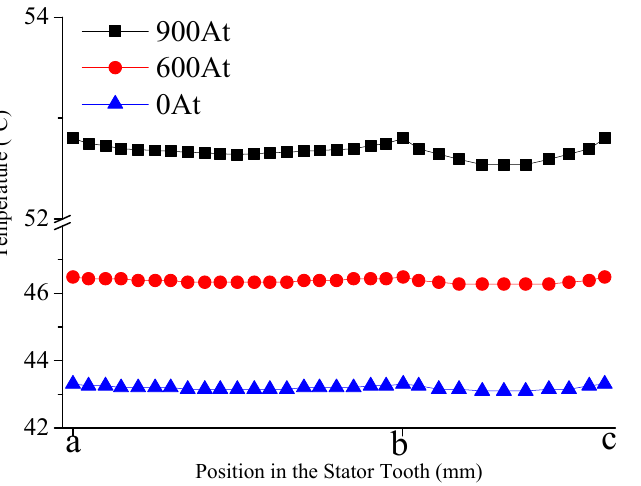
Figure 12. Temperature distributions of the stator (°C); ( a ) AMMF 0 AT; ( b ) AMMF 600 AT; and, ( c ) AMMF 900 AT. Energies 2018 , 11 , x FOR PEER REVIEW